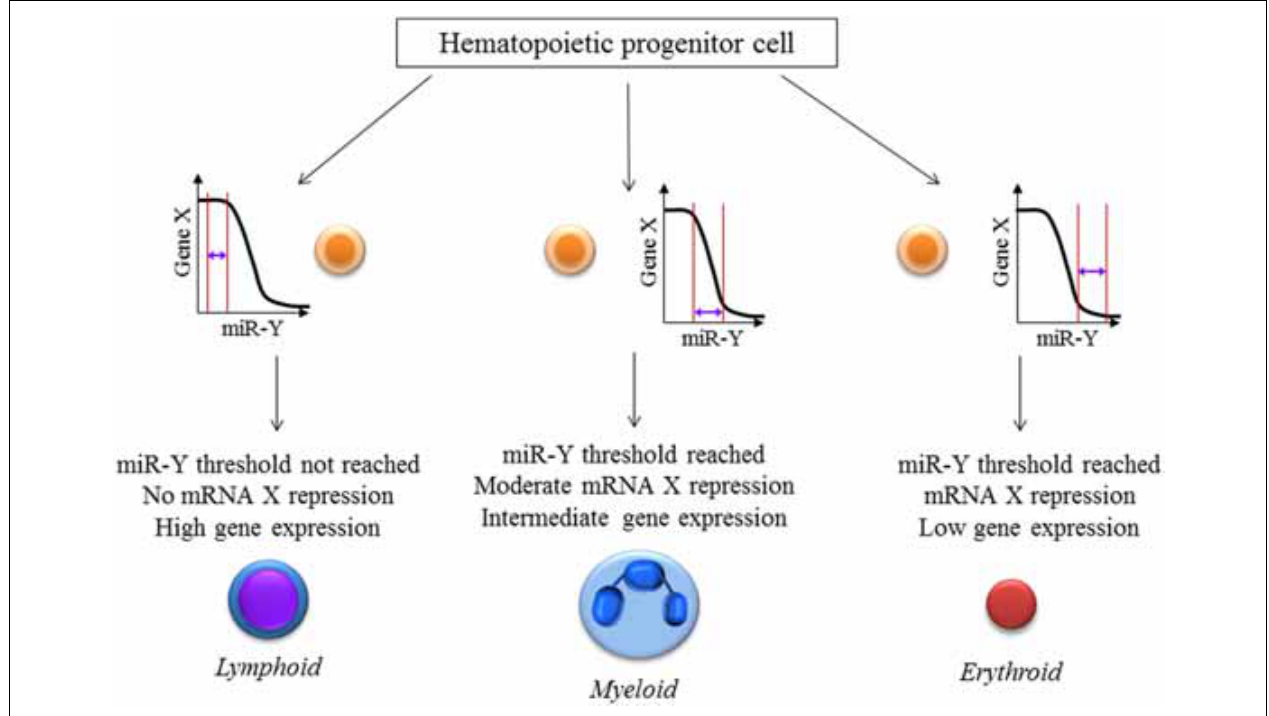
levels leading to lymphoid, myeloid and erythroid lineage differentiation respectively. Gene X is a known target of the microRNA miR-Y.These effects would be missed if single-cell measurements of X and miR-Y were not performed which reiterates the necessity for newer techniques and analyses especially at the single-cell